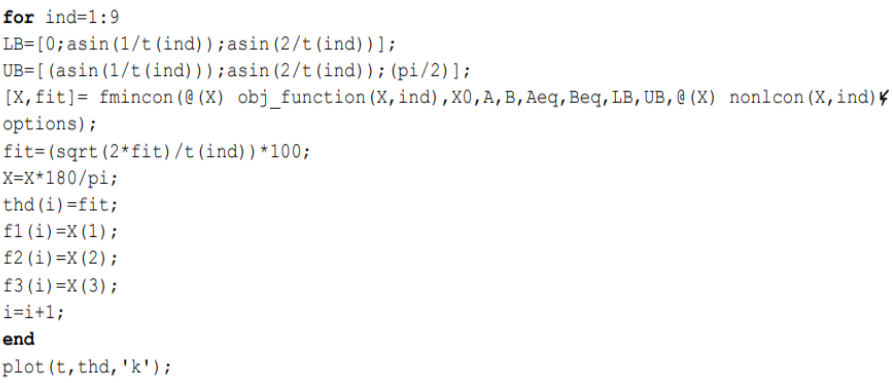
Figure 4. Code implementation of the proposed technique. The objective function and the constraints passed through the fmincon function.